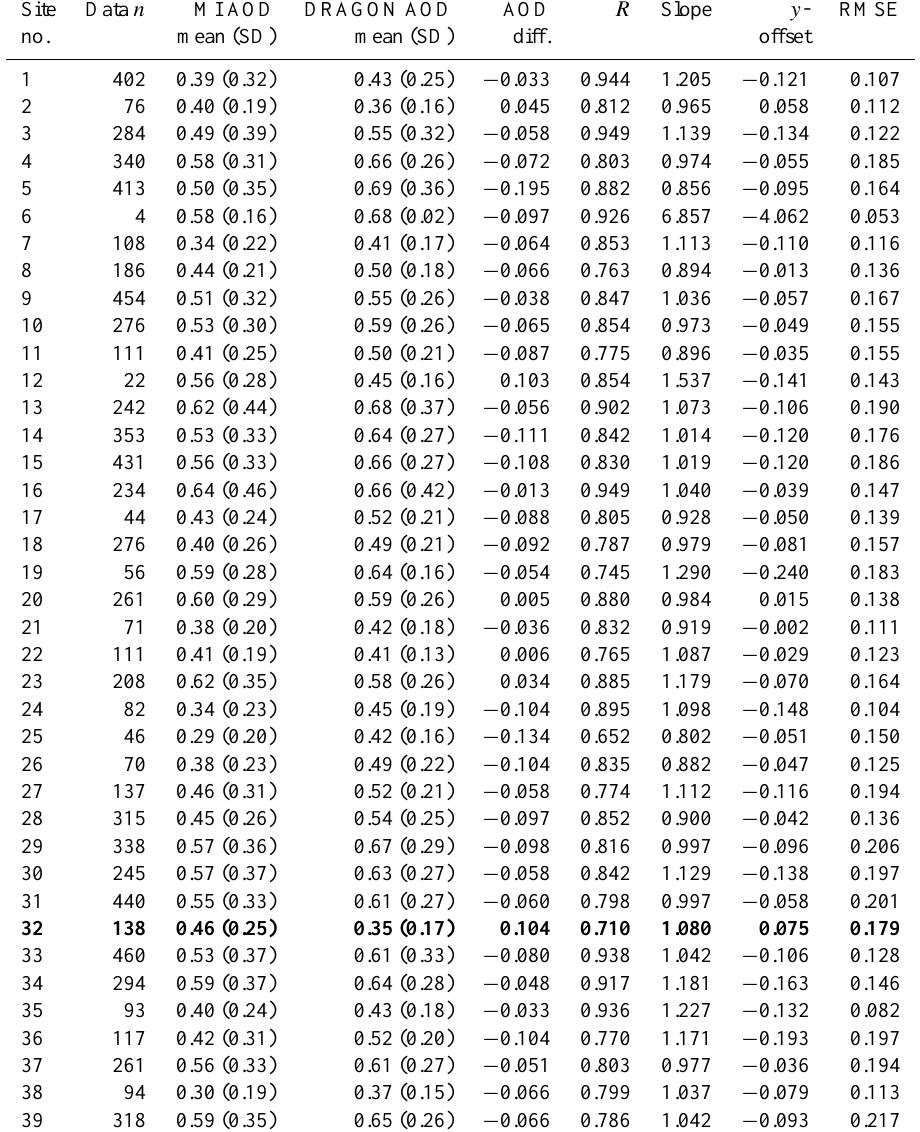
Table 4. Summary statistics of the comparison between the MI AOD (550nm) retrieved with the updated LUT and AERONET AOD (550nm). The site numbers correspond to the numbers listed in Table 1 and Fig. 9a. The sites mentioned in Sect. 4.2 are represented by bold